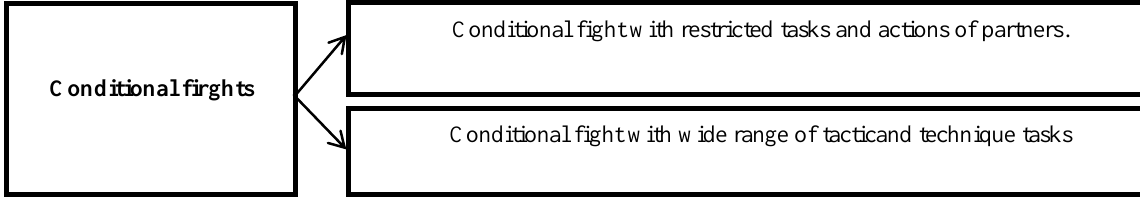
Fig.1. Classification of conditional fights in boxing. (As perI.P.Degtyariov